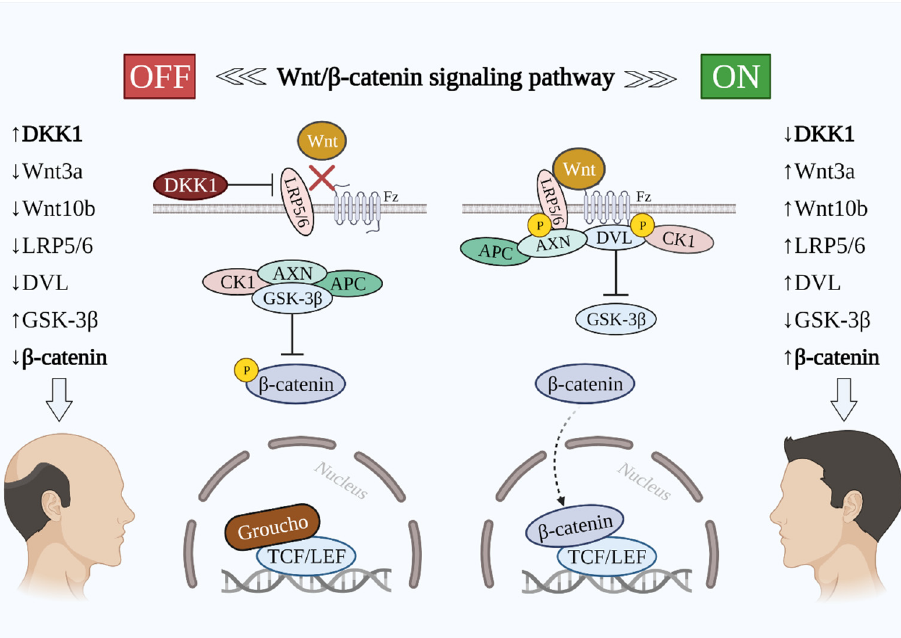
Figure 1. The implication of key molecules in the Wnt/ β -catenin signaling pathway in hair loss and growth. Wnt/ β -catenin signaling pathway OFF (on the left side): DKK1 inhibits LRP5/6 and does not allow Wnt proteins to activate the signaling pathway. Destruction complex inhibits β -catenin and its translocation into the nucleus is prevented. Transcription of Wnt-targeted genes is hindered. Wnt/ β -catenin signaling pathway ON (on the right side): Wnt binds to Fz and LRP5/6, which is followed by the phosphorylation of LRP5/6 intracellularly that leads to the DVL recruitment to Fz. β -catenin is then translocated into the nucleus and displaces Groucho. Transcription of Wnt-targeted genes takes place. Abbreviations: DKK1, dickkopf-related protein 1; Wnt, wingless and integrated- 1; Fz, frizzled; LRP5/6, low-density lipoprotein receptor-related proteins 5/6; AXN, axin; GSK3- β , glycogen synthase kinase 3 β ; CK1, casein kinase 1; DVL, dishevelled; APC, adenomatous polyposis coli; TCF/LEF, T-cell factor/lymphoid enhancer factor.